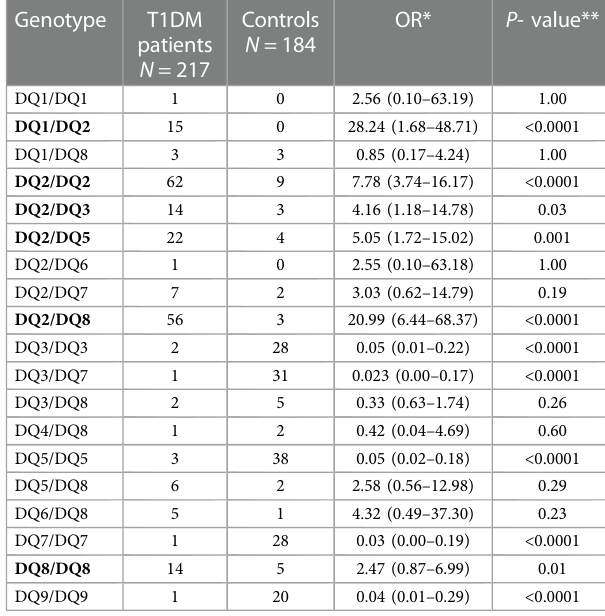
TABLE 3 Frequency of IL13 gene p . (Arg130Glu; rs20541) genotypes and alleles in Kuwaiti T1DM patients and controls. The genotype AA of rs20541 polymorphism results in an Arginine (R) residue at codon 130 while genotype GG produced Glutamine (Q) amino acid shown as homozygous RR and QQ and heterozygous RQ.